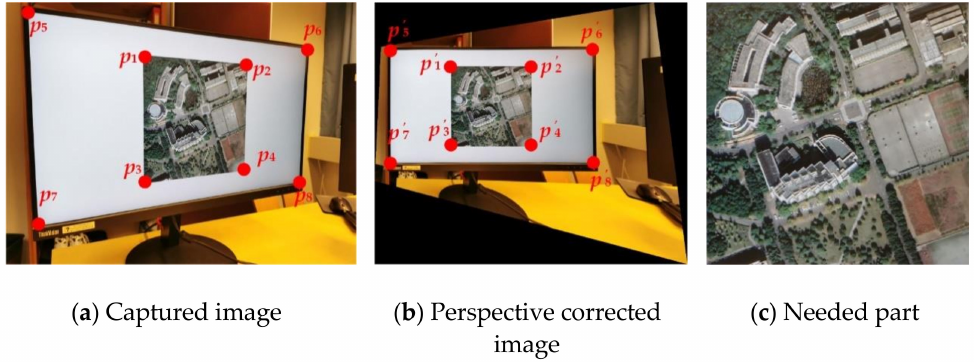
Figure 10. Perspective correction process.